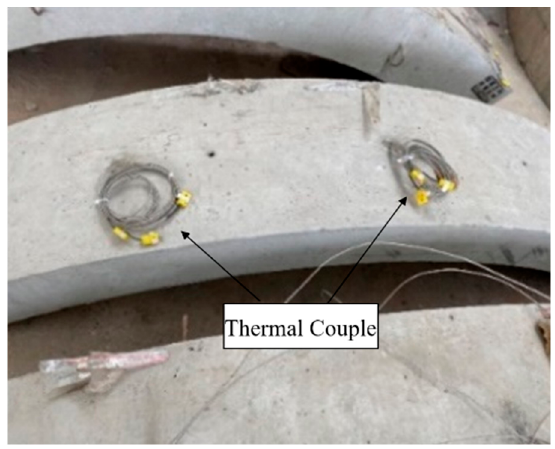
Figure 3. Embedded thermocouple at both 1/3 points of the arch.